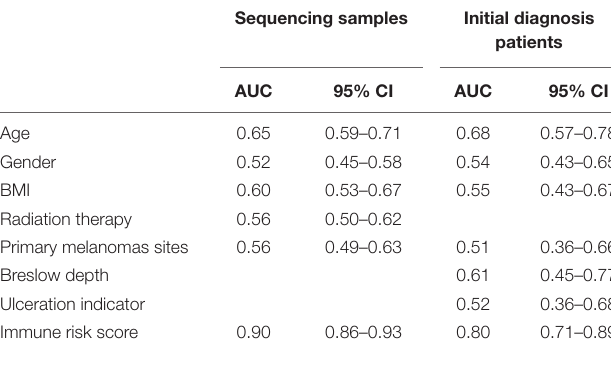
TABLE 1 | Predictive ability of immune risk score models for melanoma